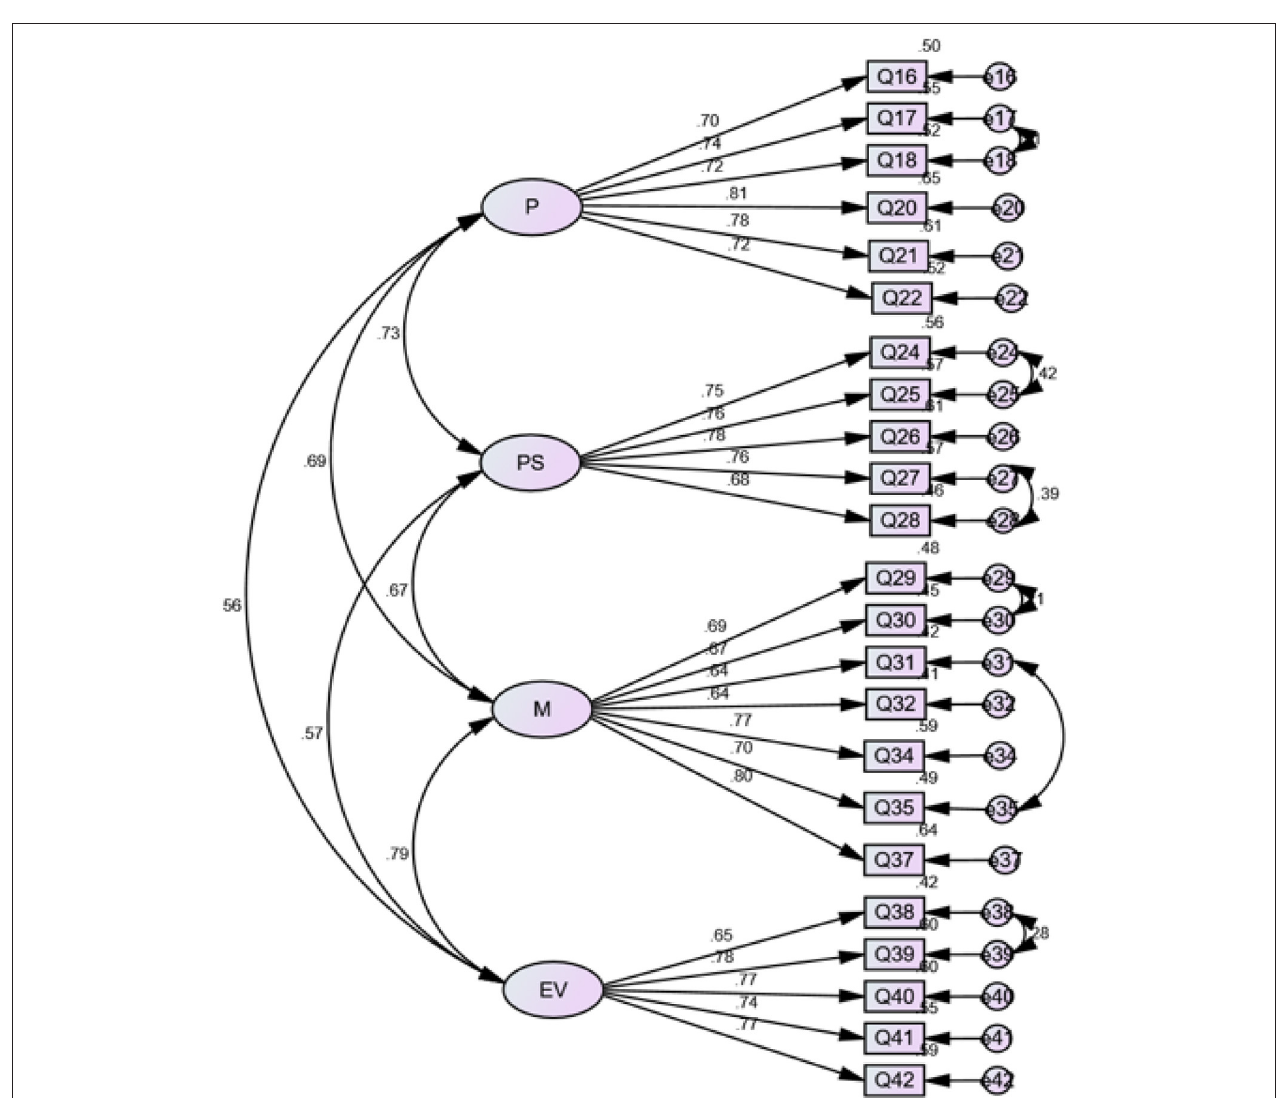
FIGURE 1 | Model D. P, planning; PS, problem-solving; M, monitoring; EV, evaluation; Q, Question.